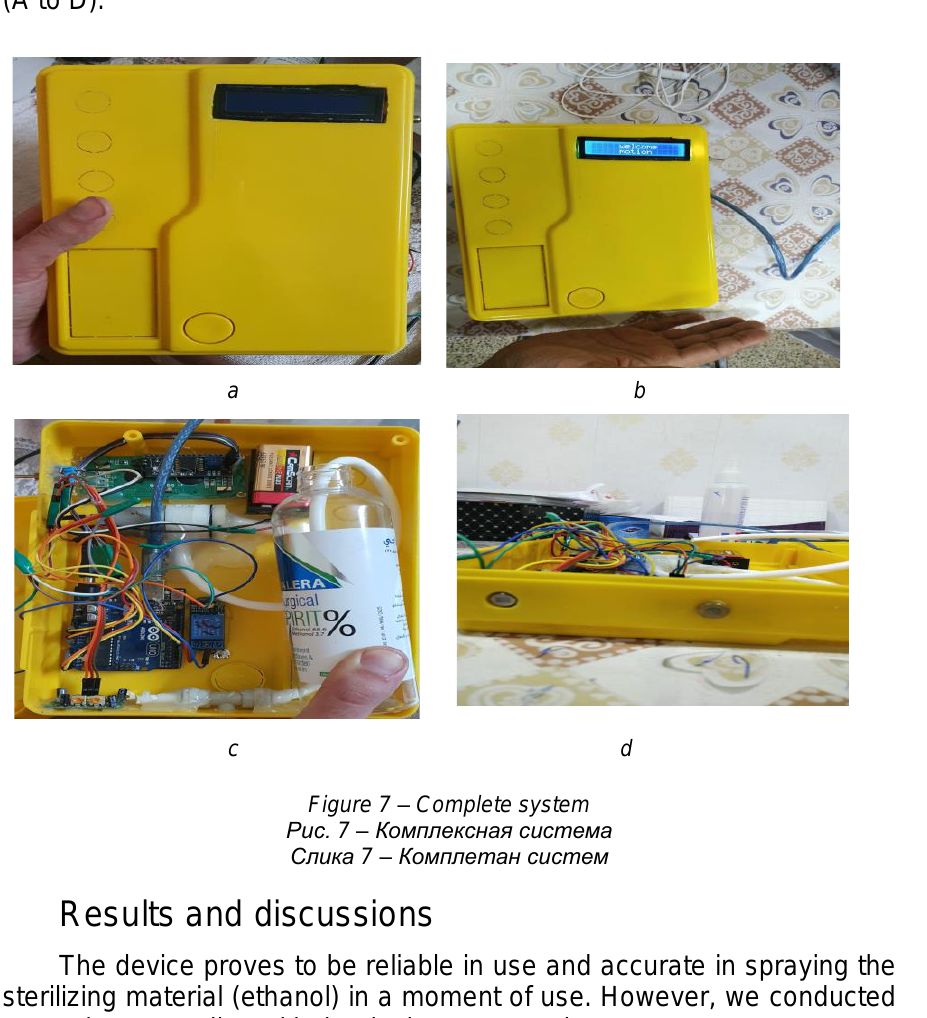
Figure 7 – Complete system Рис. 7 – Комплексная система Слика 7 – Комплетан